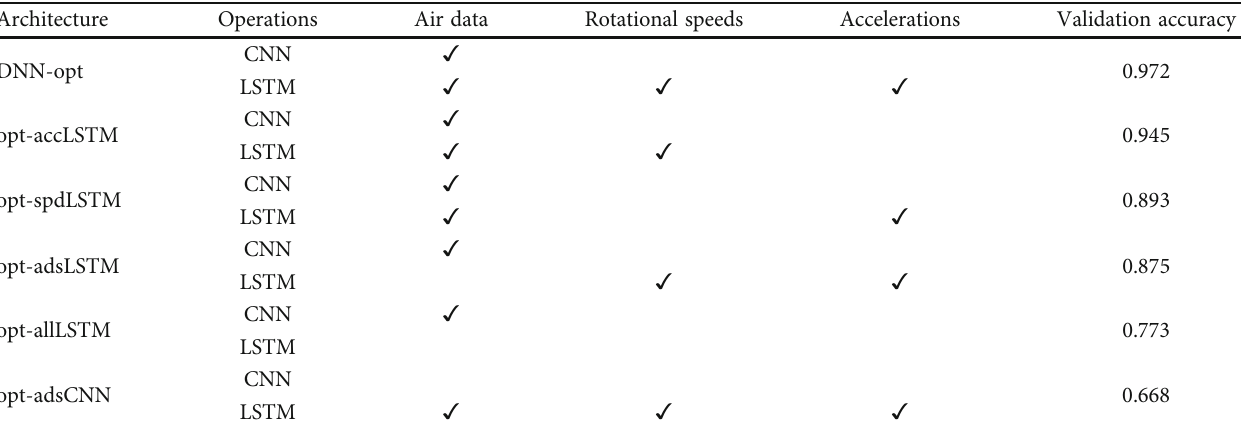
Table 8: Ablation studies on